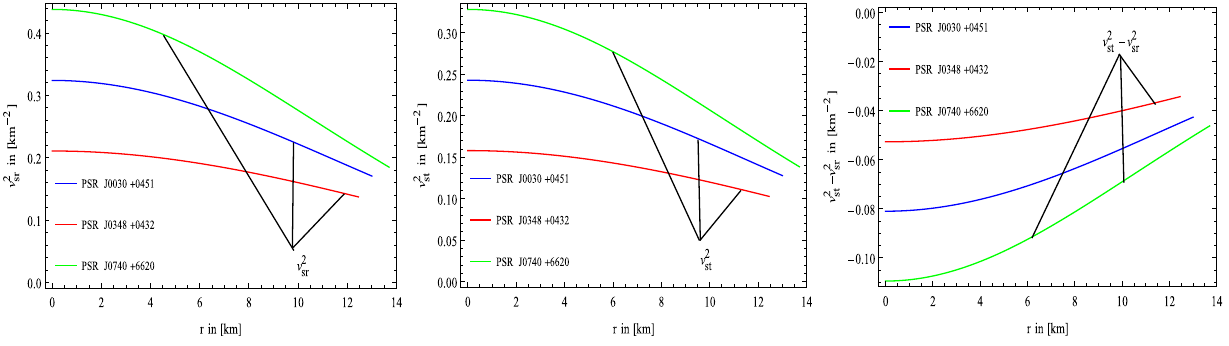
three heavy pulsars. For plotting these graphs, we use the numerical values of the constant parameters given in Table 1